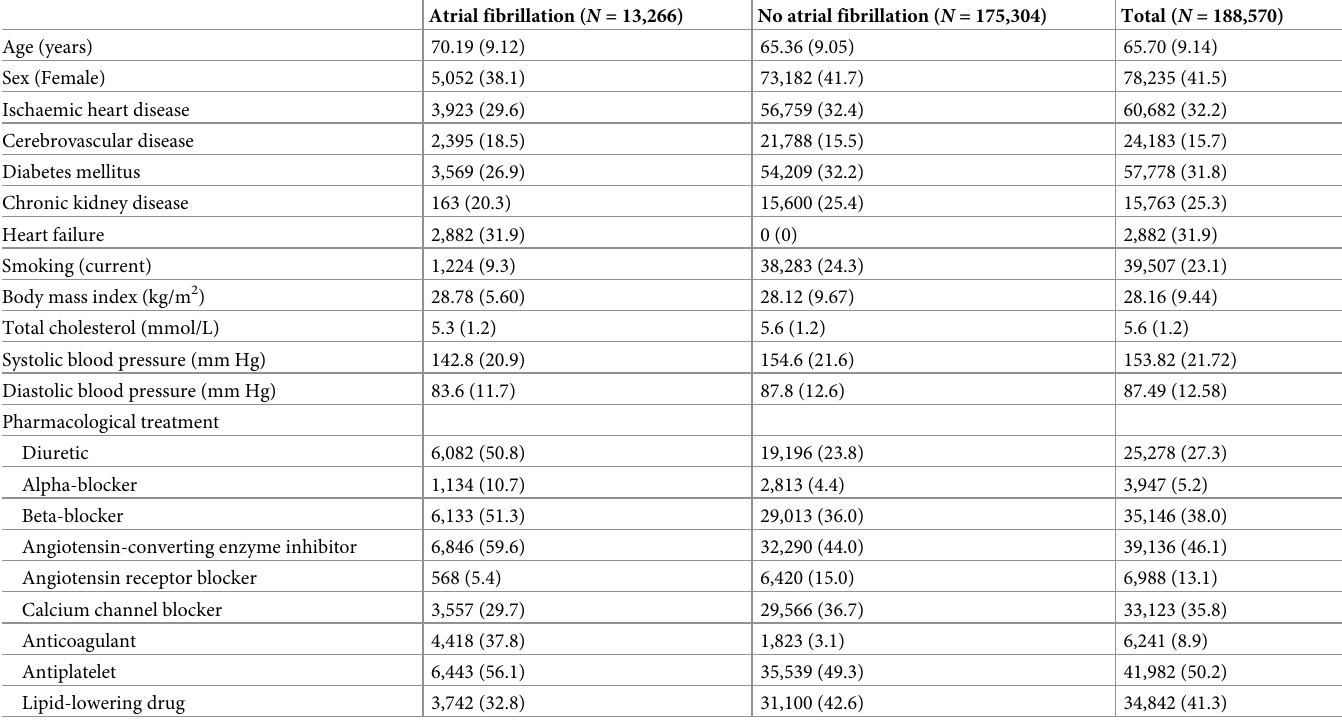
Table 1. Baseline characteristics of participants by atrial fibrillation status at